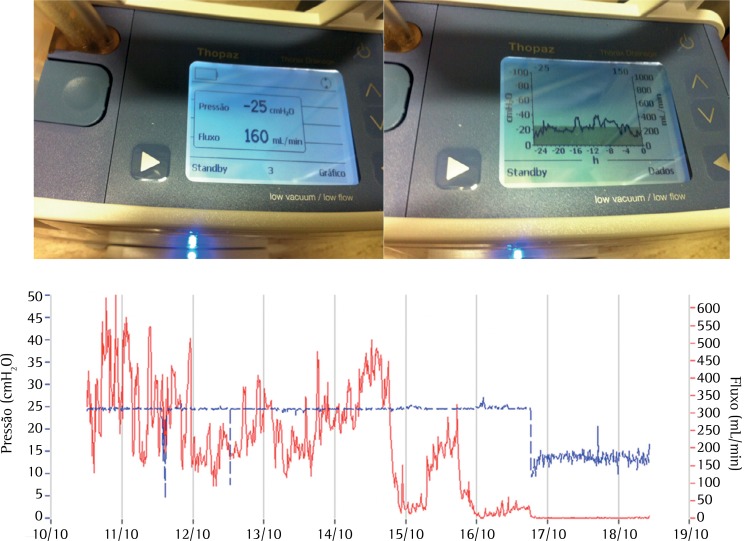
Acima Dados e gráfico no próprio dispositivo. Abaixo, os gráficos no
computador. Em vermelho, representação gráfica da perda aérea (fluxo em
mL/min); em azul, a pressão se aspiração utilizada (em cmH2O); ambas em
relação ao tempo, em dias.